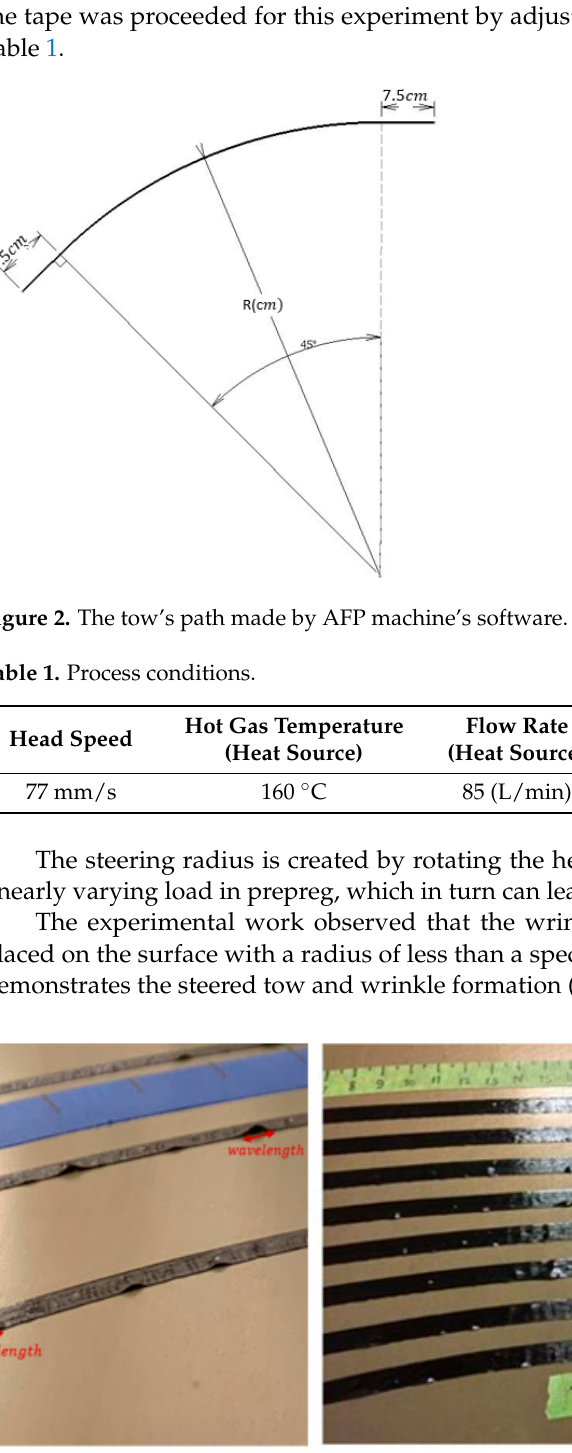
Figure 3. Steered prepreg on aluminum tool and wrinkle formation generated in tows. One of the critical parameters in the process of steering the tows is the wavelength of the wrinkle, defined as the length of an opening separation of an individual wrinkle (see Figures 3 and